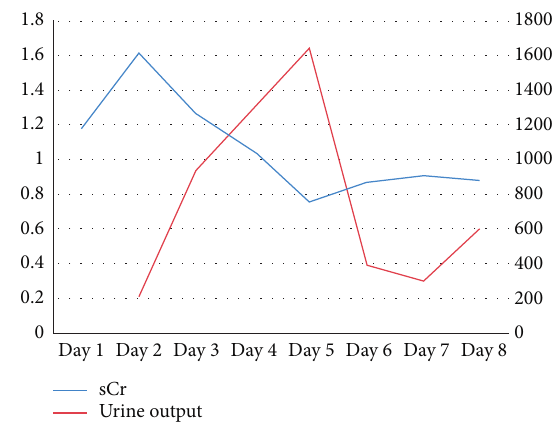
Figure 1: Serum creatinine trend (blue line) and urine output trend (red line) throughout patient's hospitalization.